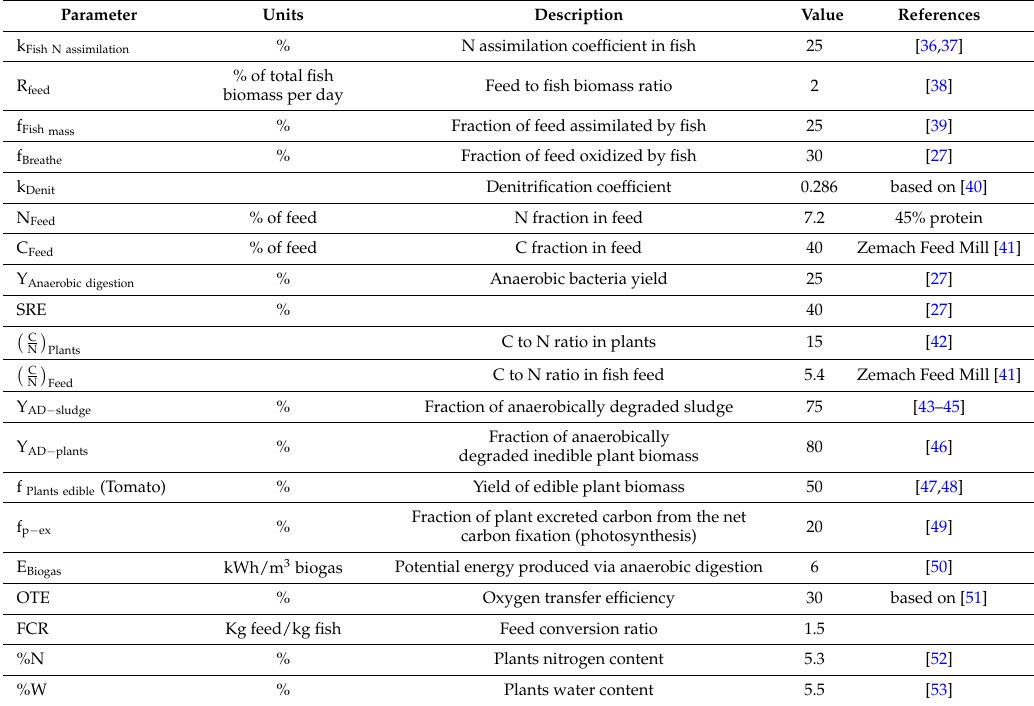
Table 1. Constants and parameters used in the